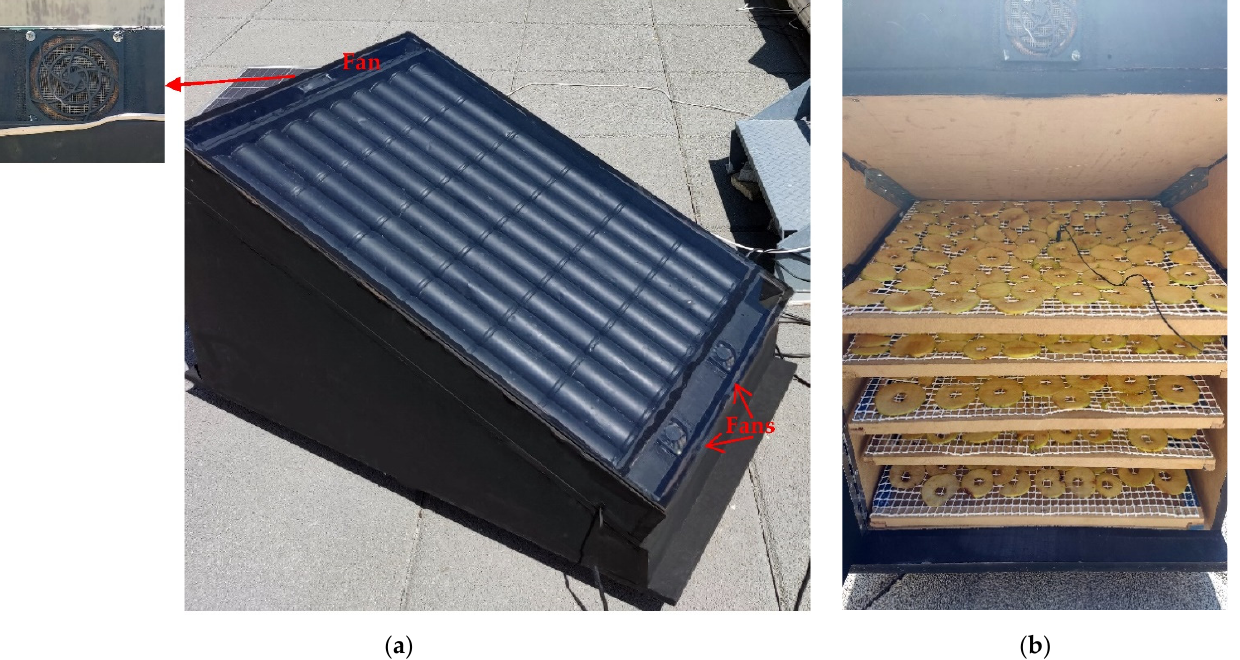
Figure 1. Prototype 1: ( a ) solar panel made with MDF wood and aluminum recycled cans. We can see the three fans, one at the top pulling air towards the aluminum cans and two at the bottom directing air to the drying chamber below. ( b ) Dryer chamber with apple slices in trays during dehydration process.